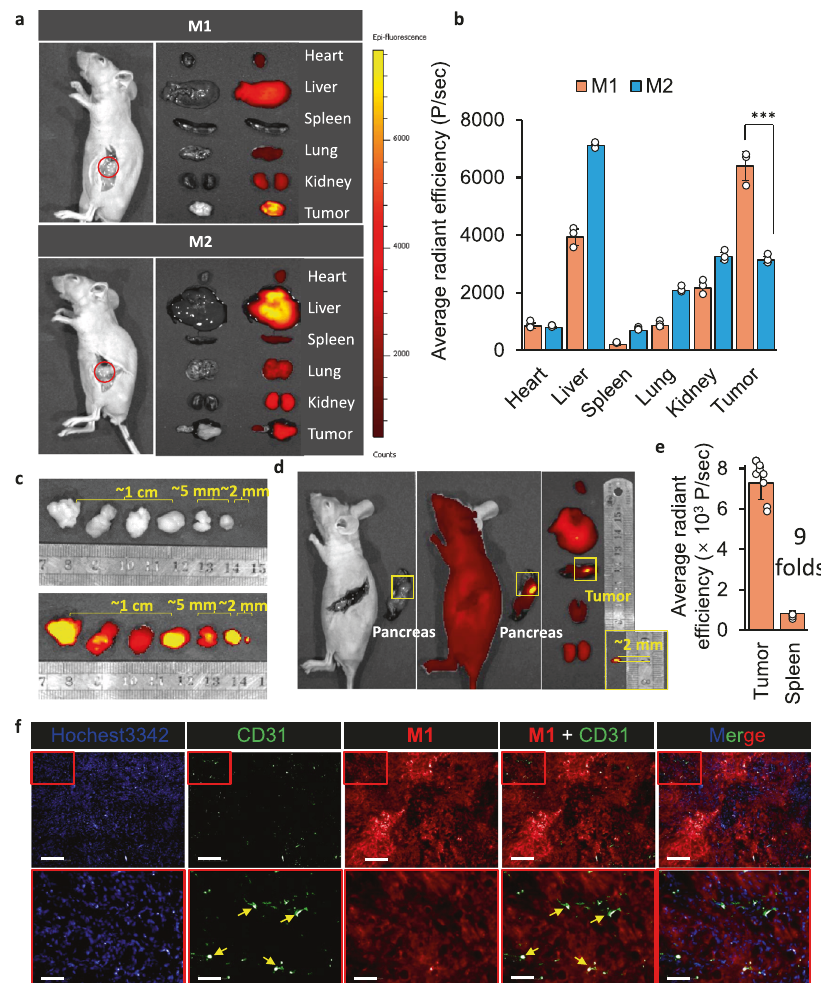
Fig. 7 The BIVA probe enhance orthotopic pancreatic tumor imaging in vivo. a The in vivo NIR images of small orthotopic pancreatic tumor by M1 and M2 , and the ex vivo of organ biodistribution including heart, liver, spleen, lung, kidney, and tumor. The mean of three biological replicates is shown ( n = 3). b The quantitative analysis of average fl uorescence intensity per organ area p = 0.000844< 0.001, ( n = 3). c The in vivo NIR images of orthotopic pancreatic tumor with individual difference with the same i.v. dose administration for 12 h. The mean of fi ve biological replicates is shown ( n = 5). d The small size (~2 mm diameter) orthotopic pancreatic tumor images and its ex vivo signal distribution. e The quantitative calculation of the signal in tumor area and healthy spleen area. The mean of eight biological replicates is shown. ( n = 10) f The tumor histochemical staining with Hochest3342 (blue), CD31 (green) and M1 (red) post i.v . injection of M1 for 48 h. The yellow arrows pointed at the blood vessels. Bars of the up layer: 200 μ m; Bars of the bottom layer: 50 μ m. Data: mean ± standard deviation. Injection dose (i.v. administration): 16 mg/kg. Statistical analysis: one-way t test followed by post hoc Tukey ’ s test, *** p <